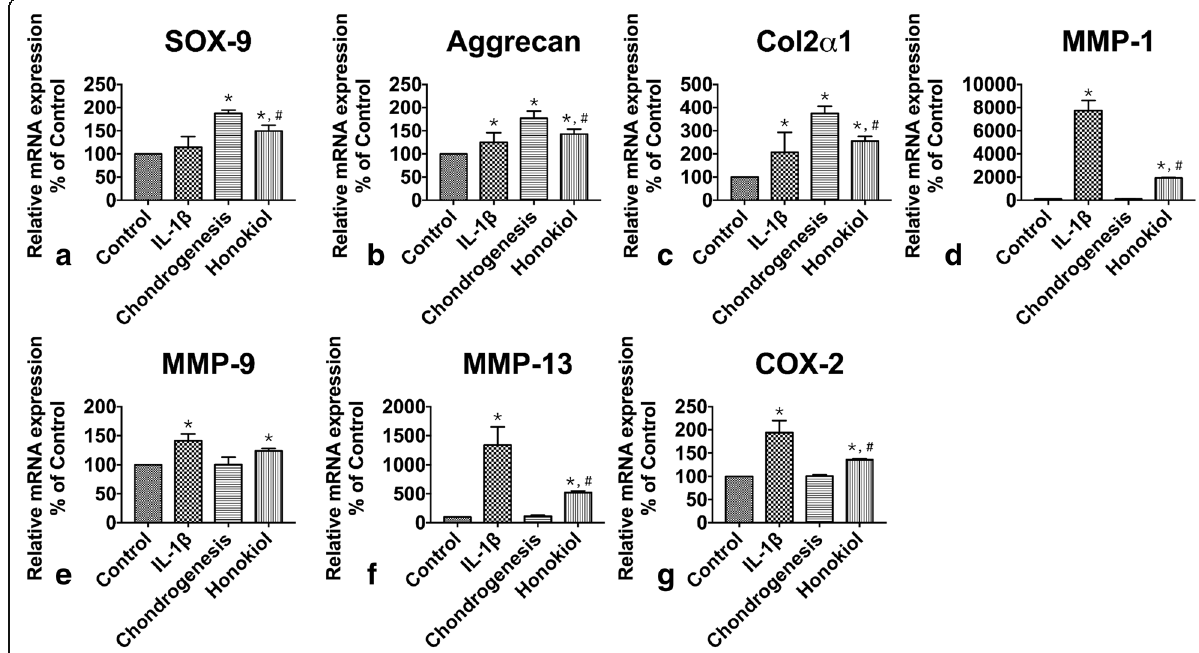
Fig. 5 The effects of honokiol on expressions of Caspase-3, SOX-9, Aggrecan, Col2 α 1, MMP-1, MMP-9, MMP-13 and COX-2. 2nd passage hUC-MSCs were cultured in pellets with chondrogenic medium, cells were treated with IL-1 β (10 ng/ml) and honokiol (25 μ M). After 2 weeks, Gene expression was evaluated by qRT-PCR. a : SOX-9, b : Aggrecan, c : Col2 α 1, d : MMP-1, e : MMP-9, f : MMP-13, g : COX-2. Data was analyzed by using the 2 - ΔΔ CT method. All results were presented as mean ± SD ( n = 9); p * < 0.01 versus control; p # < 0.01 versus IL-1 β alone (10 ng/ml IL-1 β without